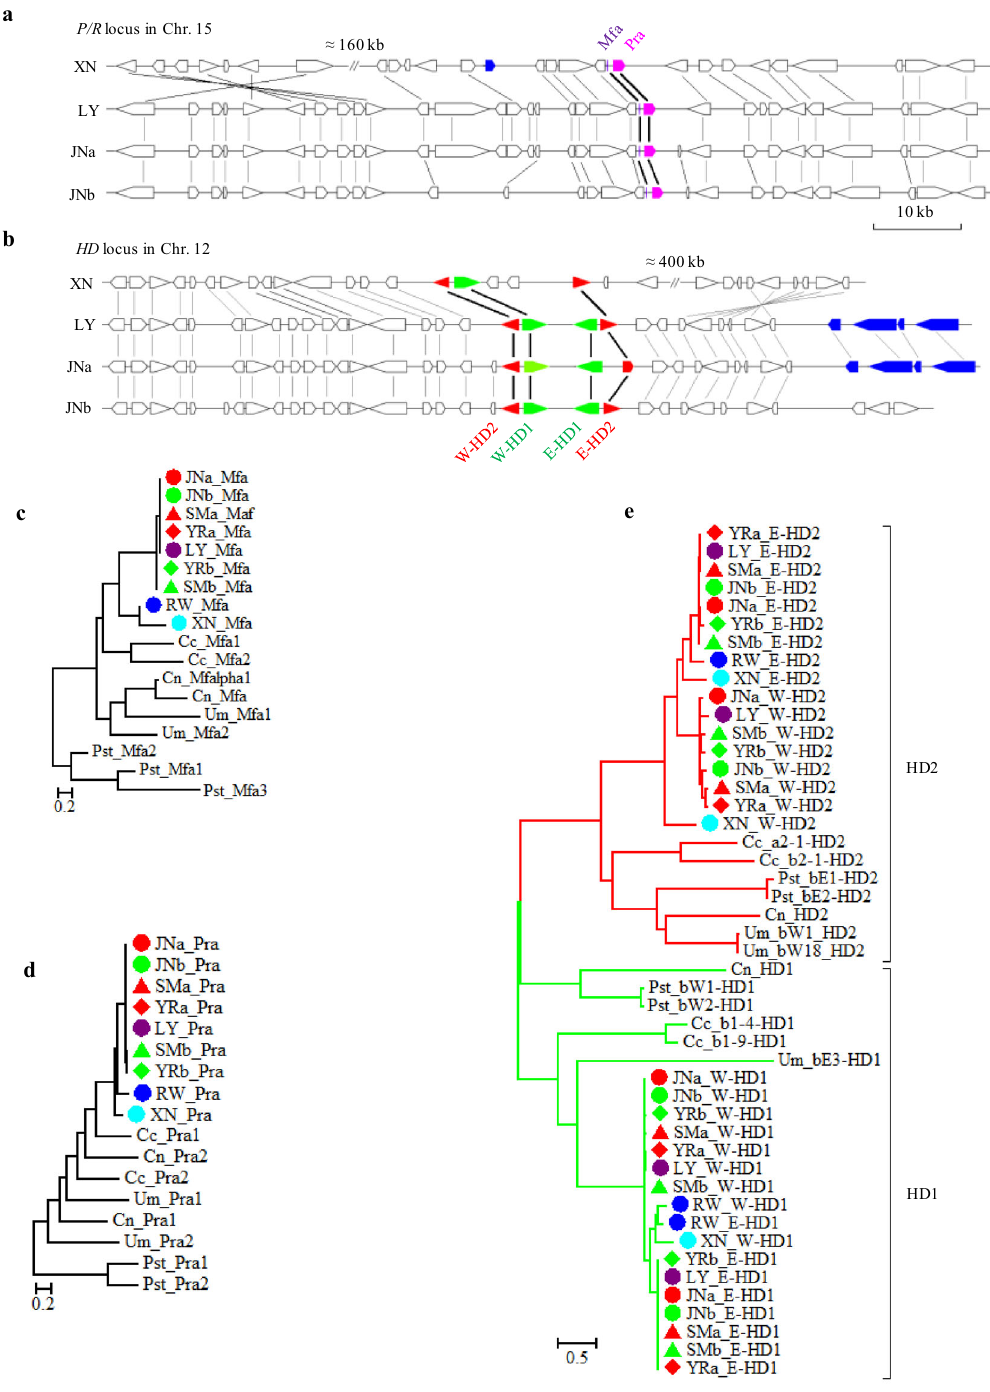
Fig. 6 Organization of mating-type loci of Rhizoctonia spp. and phylogenetic relationship with other basidiomycetes. a Structure and synteny of the pheromone and pheromone receptor ( P/R ) locus in JNa, JNb, LY, and XN. P/R locus was located in the chromosome (Chr.) 15 in LY, XN, or JN strain (Chr. 15A for JNa and Chr. 15B for JNb). Mfa (purple) and Pra (amaranth) for potential pheromone and pheromone receptor genes, respectively; transposase genes in blue; double slash for insertion with the size showed nearby. b Collinearity relationship of homeodomain ( HD ) loci in Rhizoctonia spp.. HD locus was a duplicate in proximity located in Chr. 12, assigned as W - and E - HDs with HD1 in green and HD2 in red. c – e Phylogenetic relationships of Rhizoctonia Mfa ( c ), Pra ( d ), and HDs ( e ) with some selected basidiomycete fungi. Pheromone (Mfa) proteins were collected and shown as species_protein name (accession No.): JNa_Mfa (chr. 15A: 993630-749), JNb_Mfa (chr. 15B: 929651-770), SMa_Mfa (scaffold034: 404386-505), SMb_Mfa